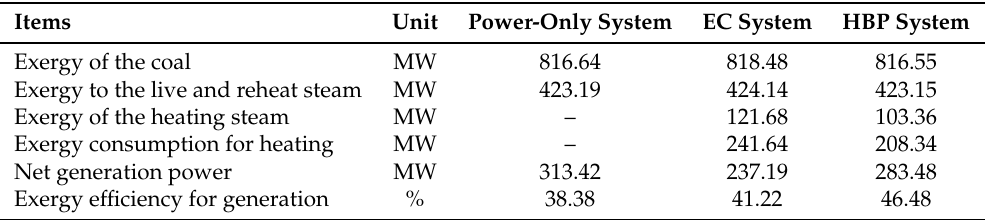
Table 6. Novel exergy analysis of the systems.